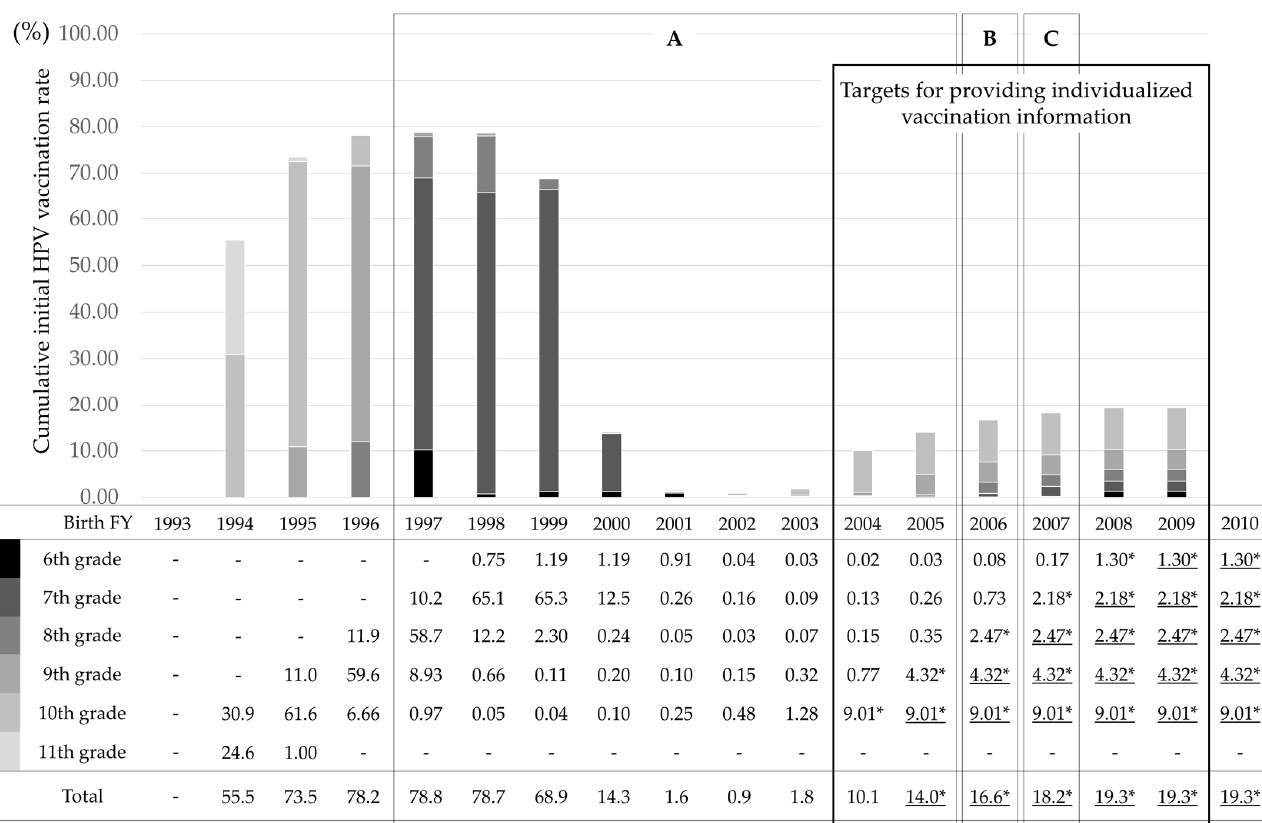
vaccination targets FY2022 to 2024. B. Targets for routine vaccination in FY2022 and catch-up vaccination in FY 2023 to 2024. C. Targets for routine vaccination in FY2022 to 2023 and catch-up